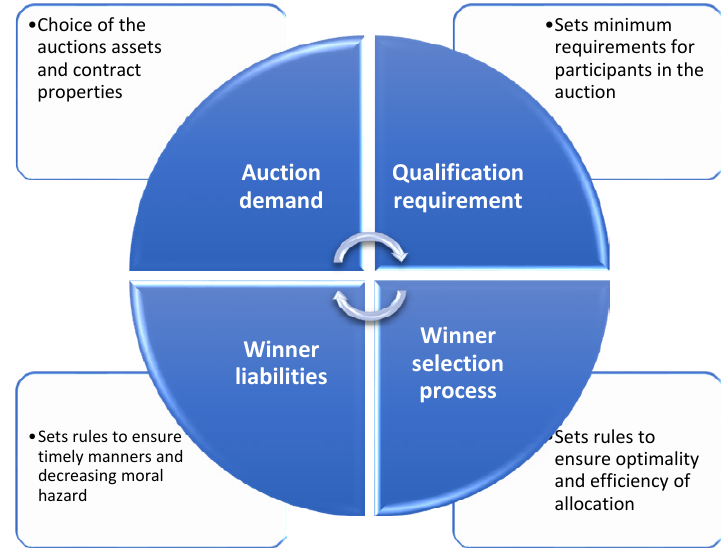
Fig. 2. The influential components on auction design (Grenadier and Wang, 2005; IRENA, 2017)